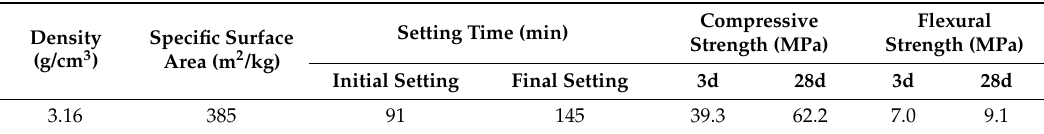
Table 1. Properties of Portland cement.